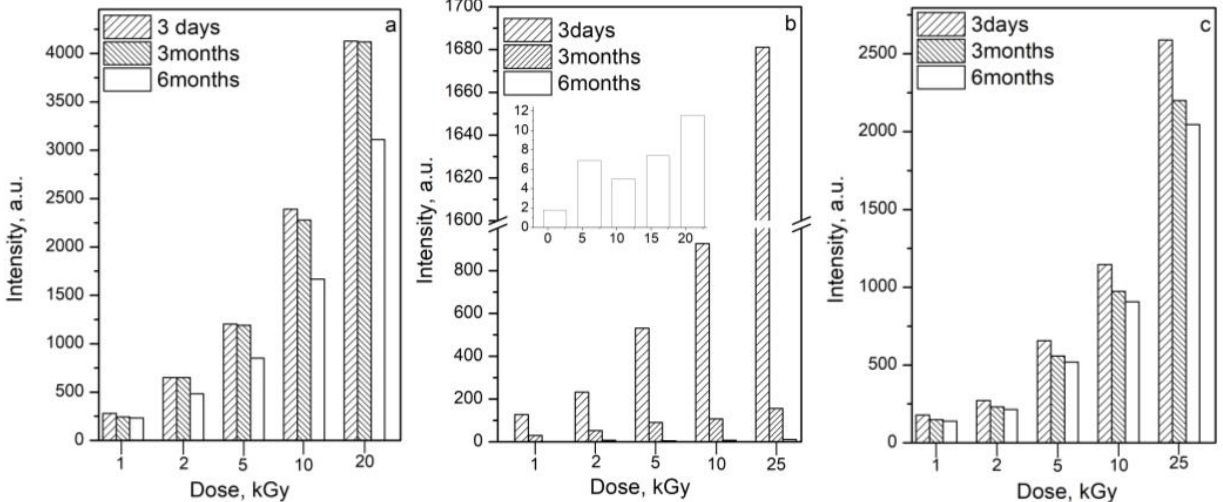
Figure 7. Time stability of the free radicals recorded for: ( a ) DL-proline; ( b ) L-proline, where the small graph shows the EPR signal intensity after six months of storage; and ( c ) cysteine.